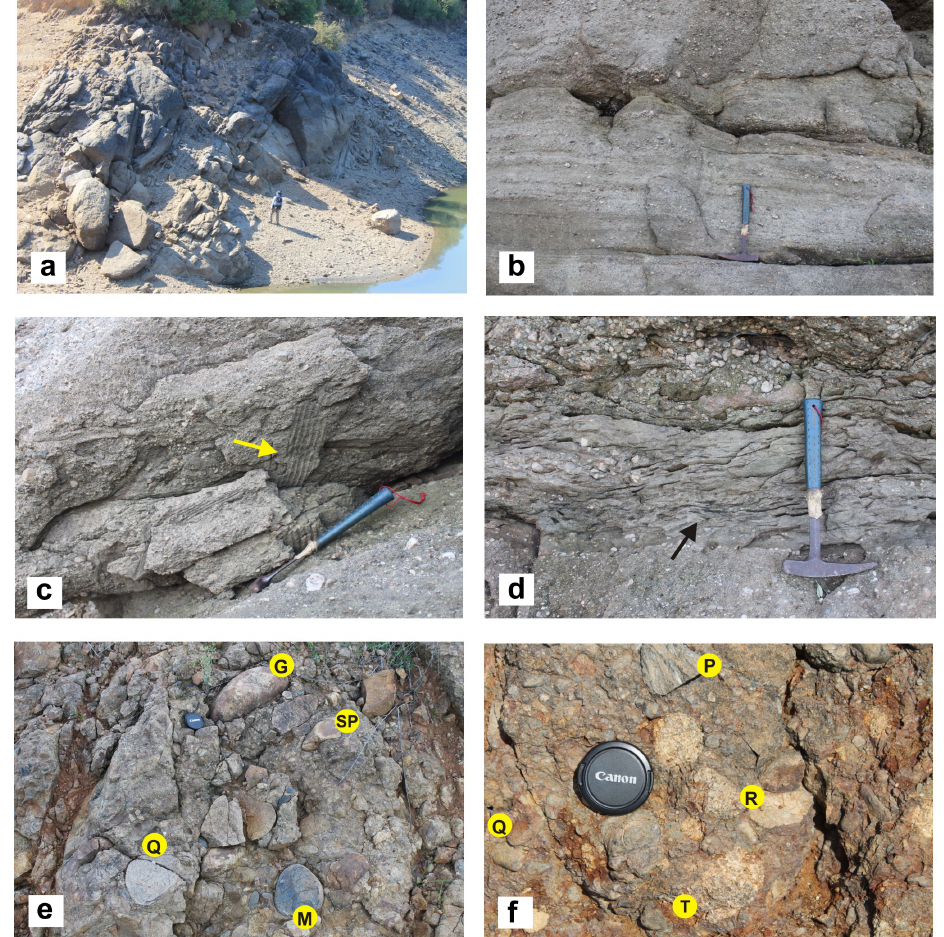
Figure 4. Photographs of the Carboniferous sedimentary rocks of the Santa Susana Formation lower member: (a) view of dipping meter-thick beds of medium–coarse grained sandstone intercalated with conglomerate; (b) planar-bedded coarse-grained sandstone; (c) plant imprints in sandstone; (d) conglomerate with cobbles and pebbles of granite (G), quartzite (Q), silicic porphyry (SP), and mafic volcanic rock (M); (e, f) conglomerate with pebbles of rhyolite (R), phyllite (P), felsic tuff (T), and quartzite